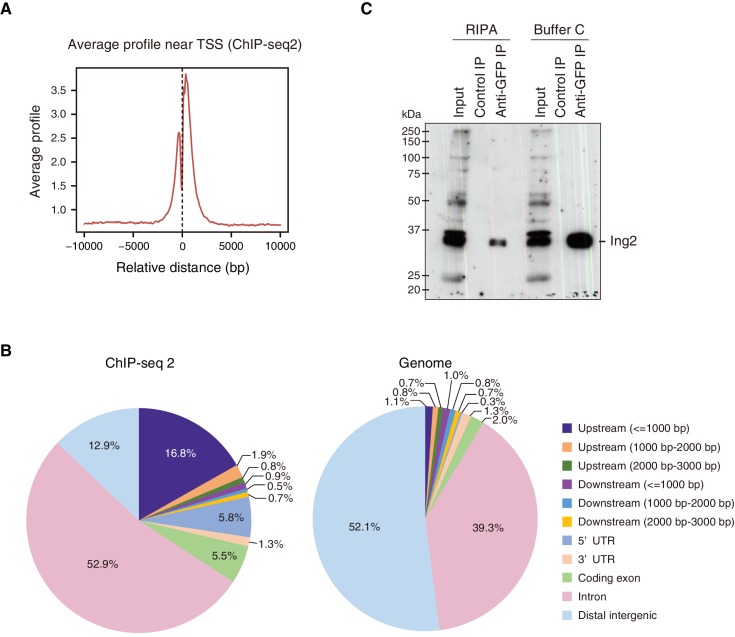
Genome-wide localization of Fam60a to gene promoters.(A) Average binding profile for Fam60a-Venus at the TSS region of all genes with binding peaks identified by ChIP-seq2. Distance is expressed relative to the TSS. (B) Peak distribution for ChIP-seq2 analysis (left panel) compared with overall composition of the mouse genome (right panel). (C) Nuclear extracts prepared from E10.5 Fam60a-Venus transgenic embryos with RIPA buffer or buffer C were subjected to immunoprecipitation with antibodies to GFP or control IgG, and the resulting precipitates were subjected to immunoblot analysis with antibodies to Ing2.